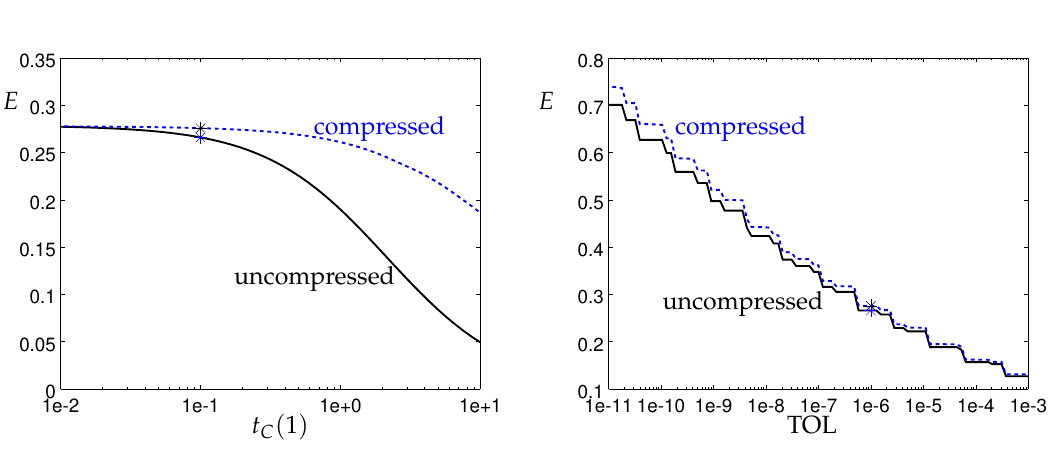
Figure 3. Theoretically estimated parallel efficiency E = T seq / ( NT par ) for variation of different parameters around the nominal scenario (marked by *). Left: varying communication bandwidth in terms of the communication time for uncompressed data. Right: varying requested